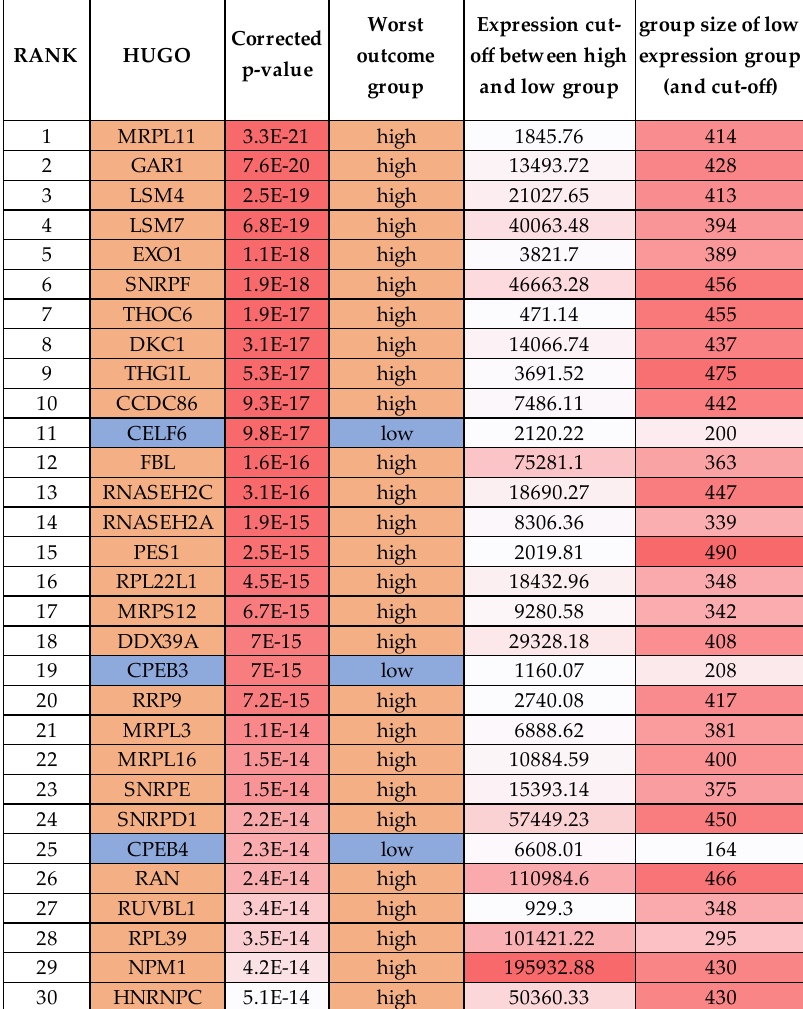
Figure 3. Top RBPs with the highest prognostic significance by the Kaplan scan method in the R2 visualisation tool.